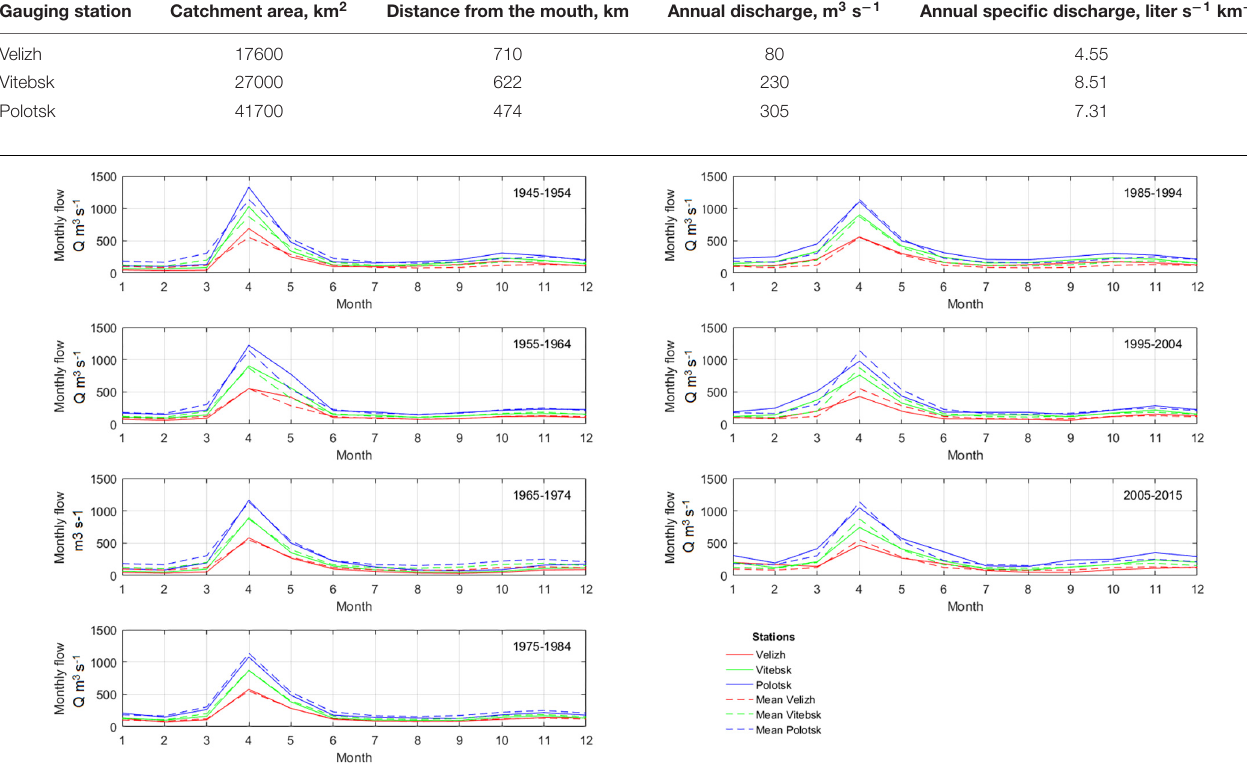
FIGURE 7 | Dynamics of monthly discharges (m 3 s − 1 ) in the Western Dvina River at the Velizh, Vitebsk and Polotsk gauging